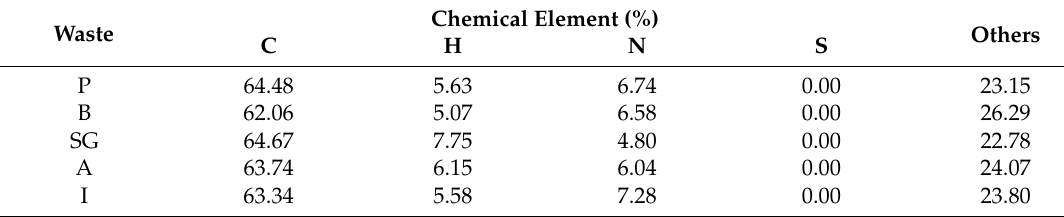
Table 1. Results of Results CNHS Analysis of different PU